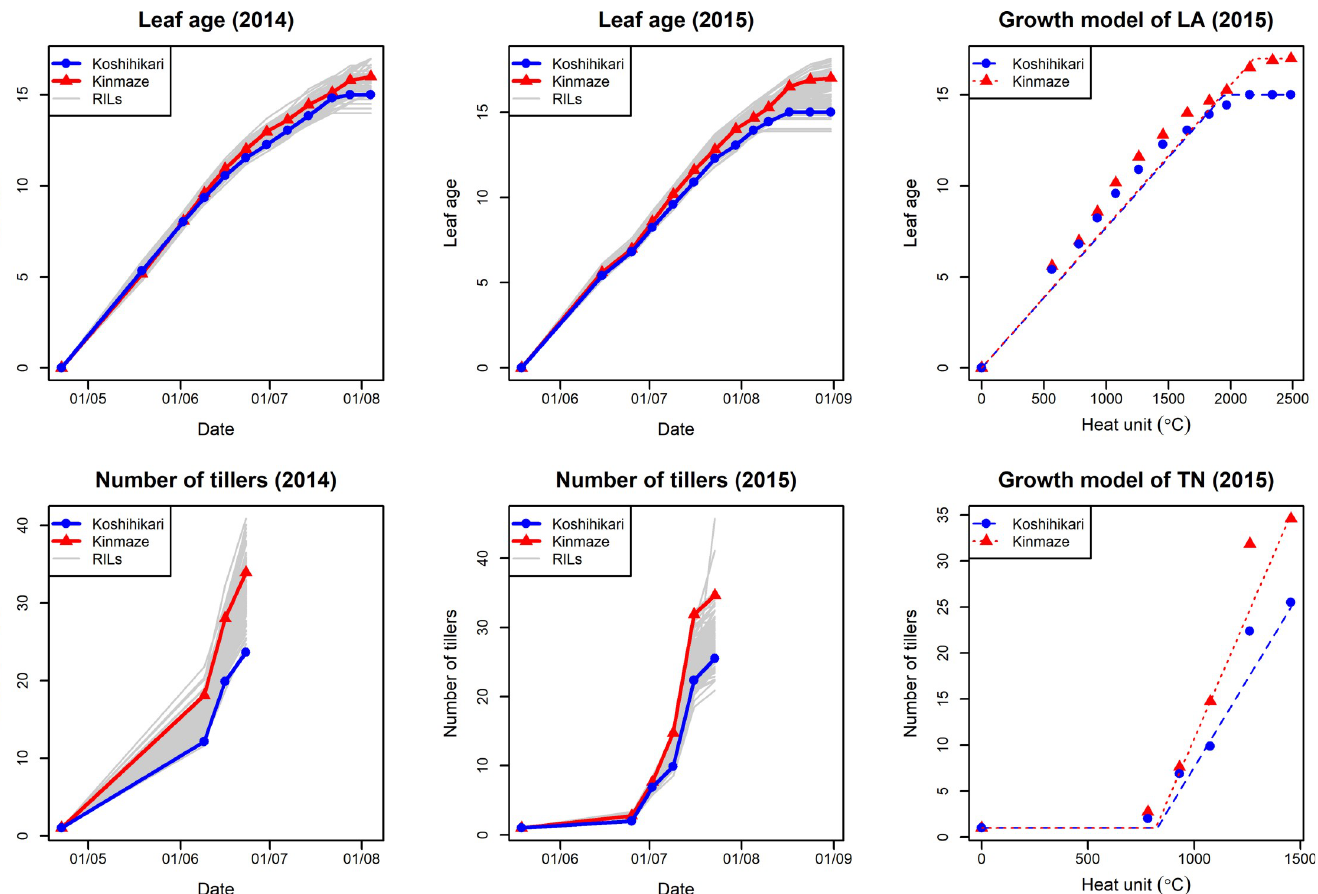
Fig 3. Growth curves and growth models of leaf age and number of tillers. The line means of both traits in 2014 and 2015 are plotted in four figures in the left side. The parents, Koshihikari and Kinmaze, and RILs are expressed as blue, red and gray lines, respectively. The growth models of those traits are shown in two figures in the right side. The growth model and the observed values of parents in 2015 are shown. Heat unit is used as horizontal axes.